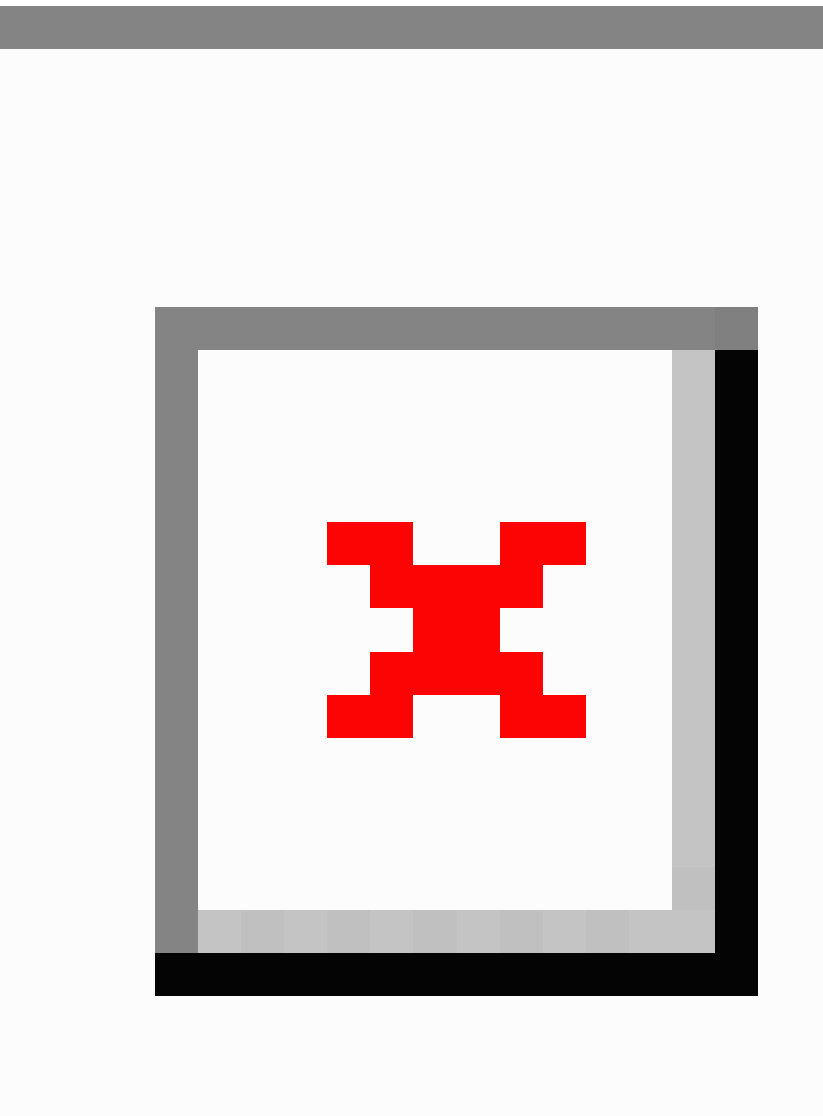
Figure 4. Self-identified user (SIU) rate for users reported having HIV, compared to the HIV incidence rate by state. The correlation between the two variables is Spearman rho=.452